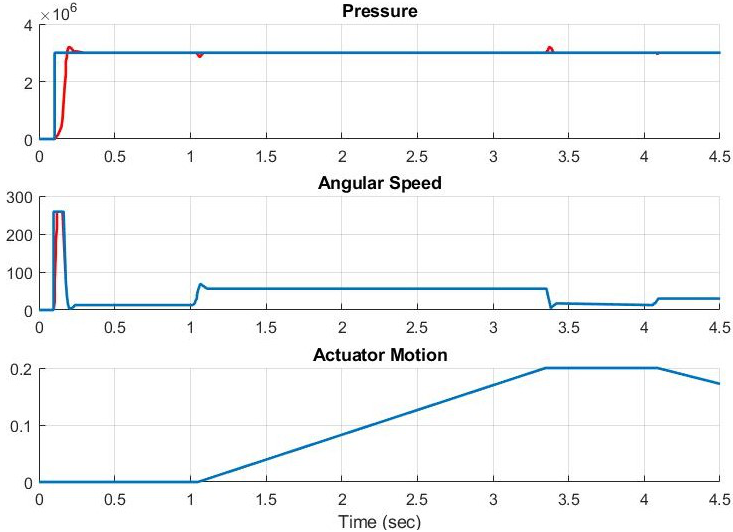
Figure 11. Simulation results.